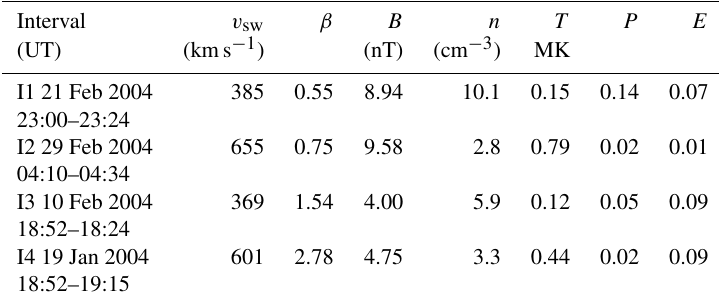
Table 1. Table of the mean plasma and spacecraft parameters in the interval organised from low to high β . Interval v sw β B n T P E (UT) (kms − 1 ) (nT) (cm − 3 ) MK I1 21 Feb 2004 385 0.55 8.94 10.1 0.15 0.14 0.07 23:00–23:24 I2 29 Feb 2004 655 0.75 0.79 0.02